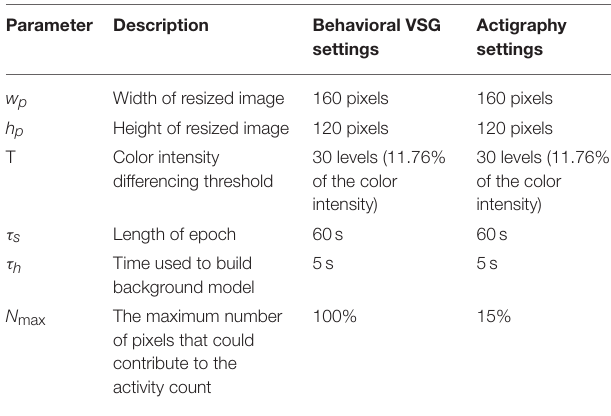
TABLE 3 | Automatic videosomongraphy (auto-VSG) system